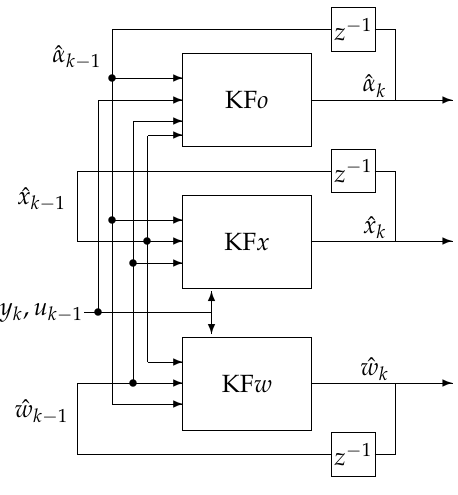
Figure 4. Triple Estimation